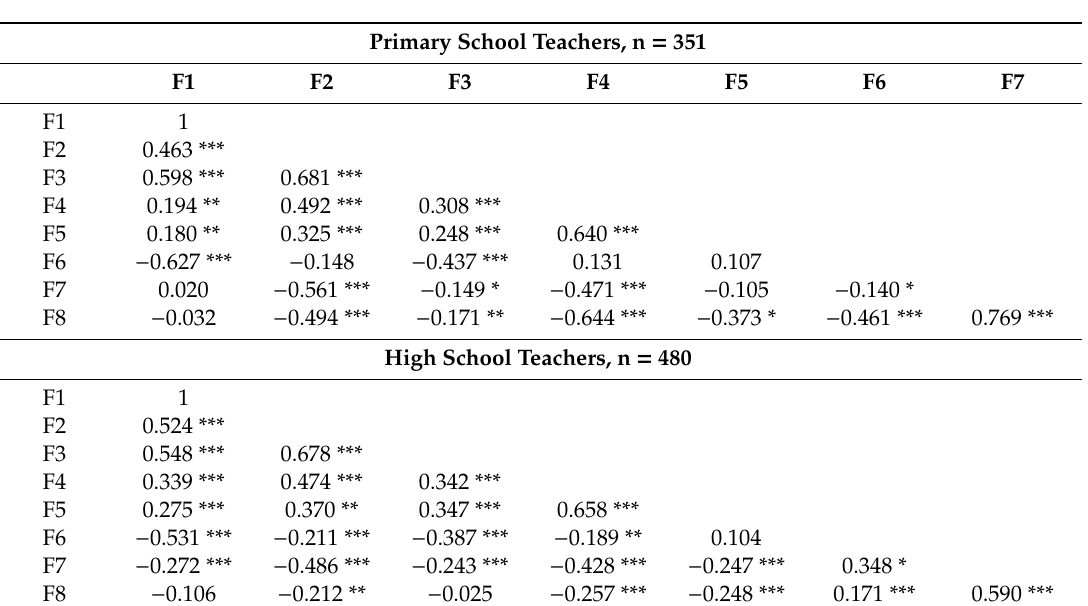
Table 1. Factor score